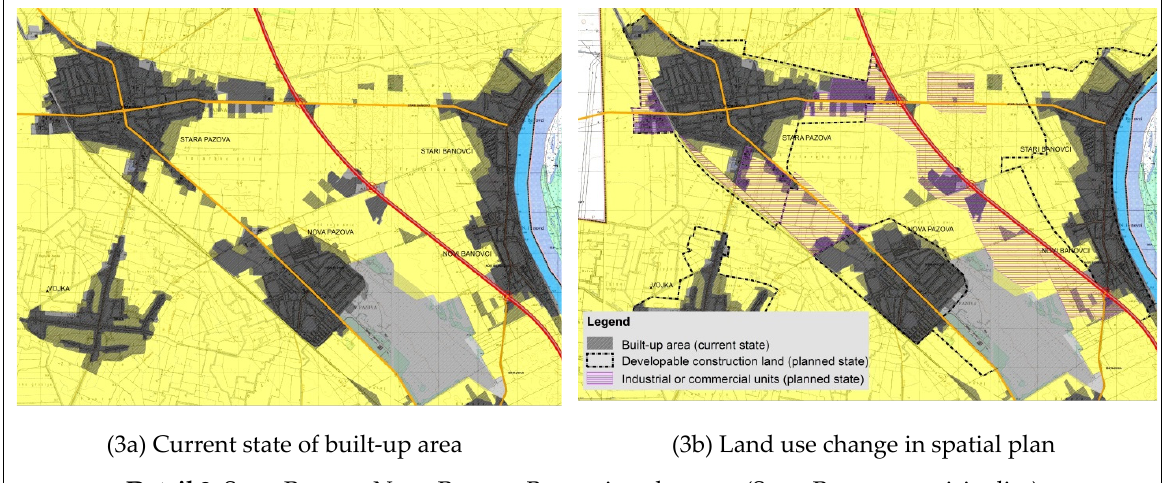
Figure 5. Detailed elaboration of agricultural land-use change [44,45].